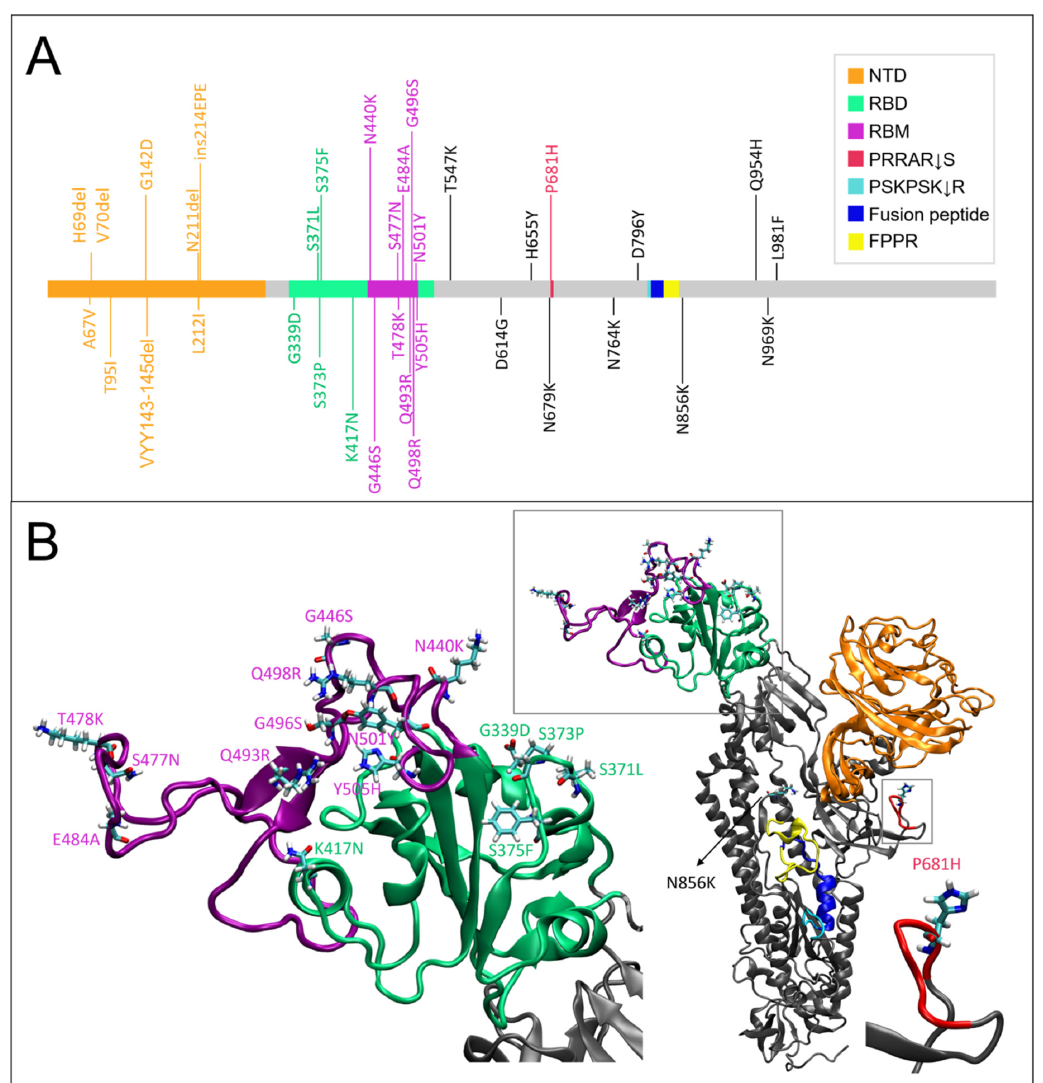
Figure 2. Domain organization and mutations of Omicron variant. ( A ) Graphical scheme of the domains in a spike monomer and Omicron mutations from aa 14 to 1273. ( B ) Cartoon representation of the representative frame (797 ns) of Omicron monomer (mon1) selected by cluster analyses. The WT numbering was maintained. The boxes detail Omicron mutations, respectively, in the RBD domain (in green) and in the cleavage sequence at the S1/S2 boundary (in red). The FCS region shows fluctuations that are comparable to the WT (comparison of S686 in Omicron with P681 in WT) even though P681 is mutated to a histidine. A mod- erate increase in fluctuations is observed in the S2 peak (comparison of D839 in Omicron with G832 in WT and C840 in Delta).